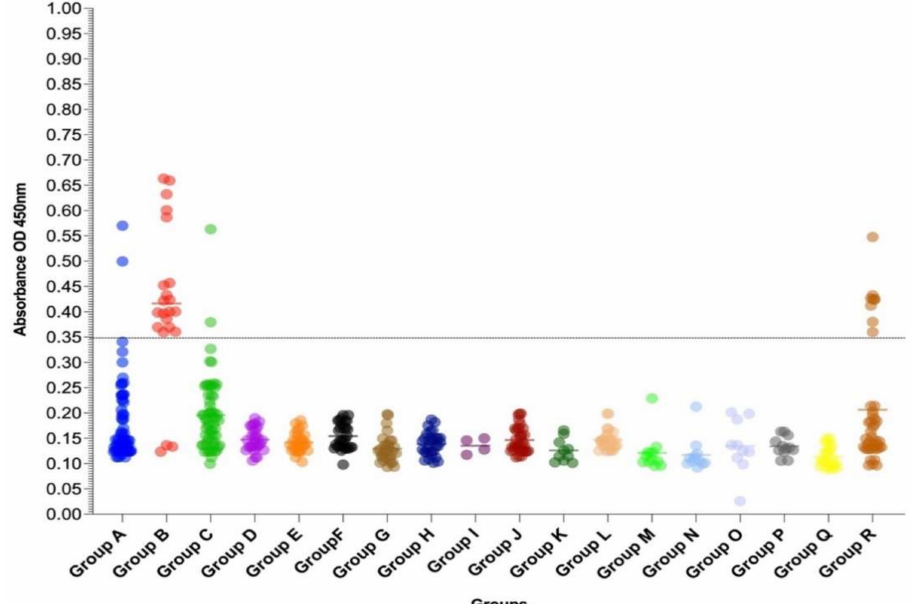
Figure 4. IgG antibody response in chikungunya patients and control groups ( n = 495) to the chikun- gunya recombinant polypeptide as determined by the MULTREC IgG-ELISA. Absorbance values obtained using the MULTREC IgG-ELISA on a panel ( n = 495) of chikungunya cases and controls. (-) represents the mean value for each group and (—) dashed lines, the cut-off value for the test (0.3503) as determined at a wavelength of 450 nm and a reference value between 620 nm and 650